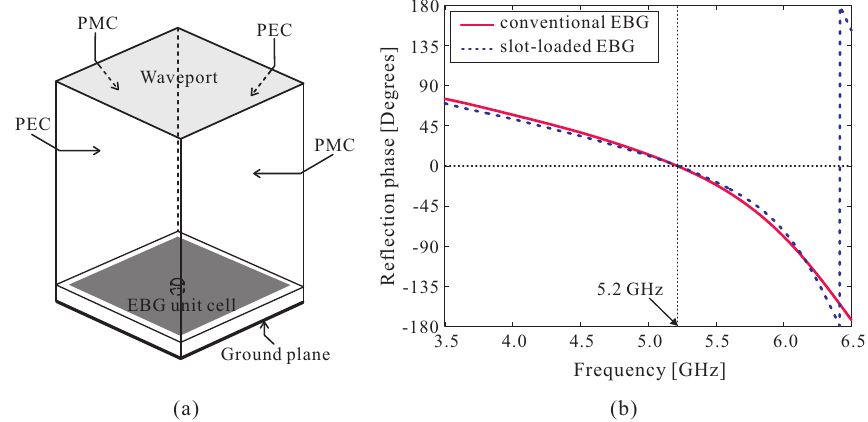
Figure 3. ( a ) A simulation model of an EBG structure for the calculation of the reflection phase; ( b ) Simulated reflection phases of EBGs. EBG: Electromagnetic band gap.